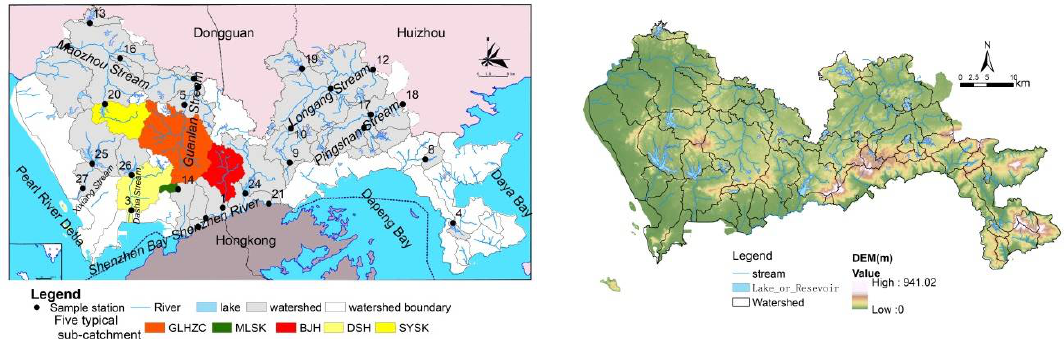
Figure 1. Sample stations and their corresponding watersheds and streams in Shenzhen, ( left ) Sample stations and the sub-catchment; ( right ) Digital elevation model (DEM) .